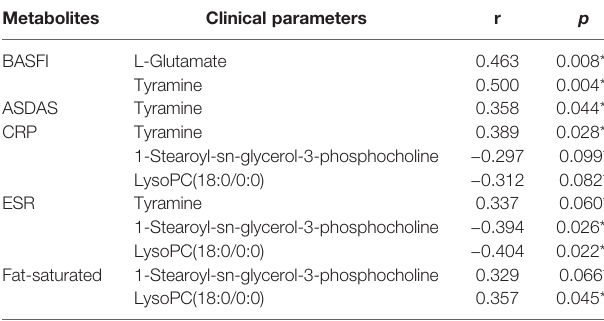
TABLE 2 | The correlation analysis of differentiated metabolites and clinical parameters among AS patients. Metabolites Clinical